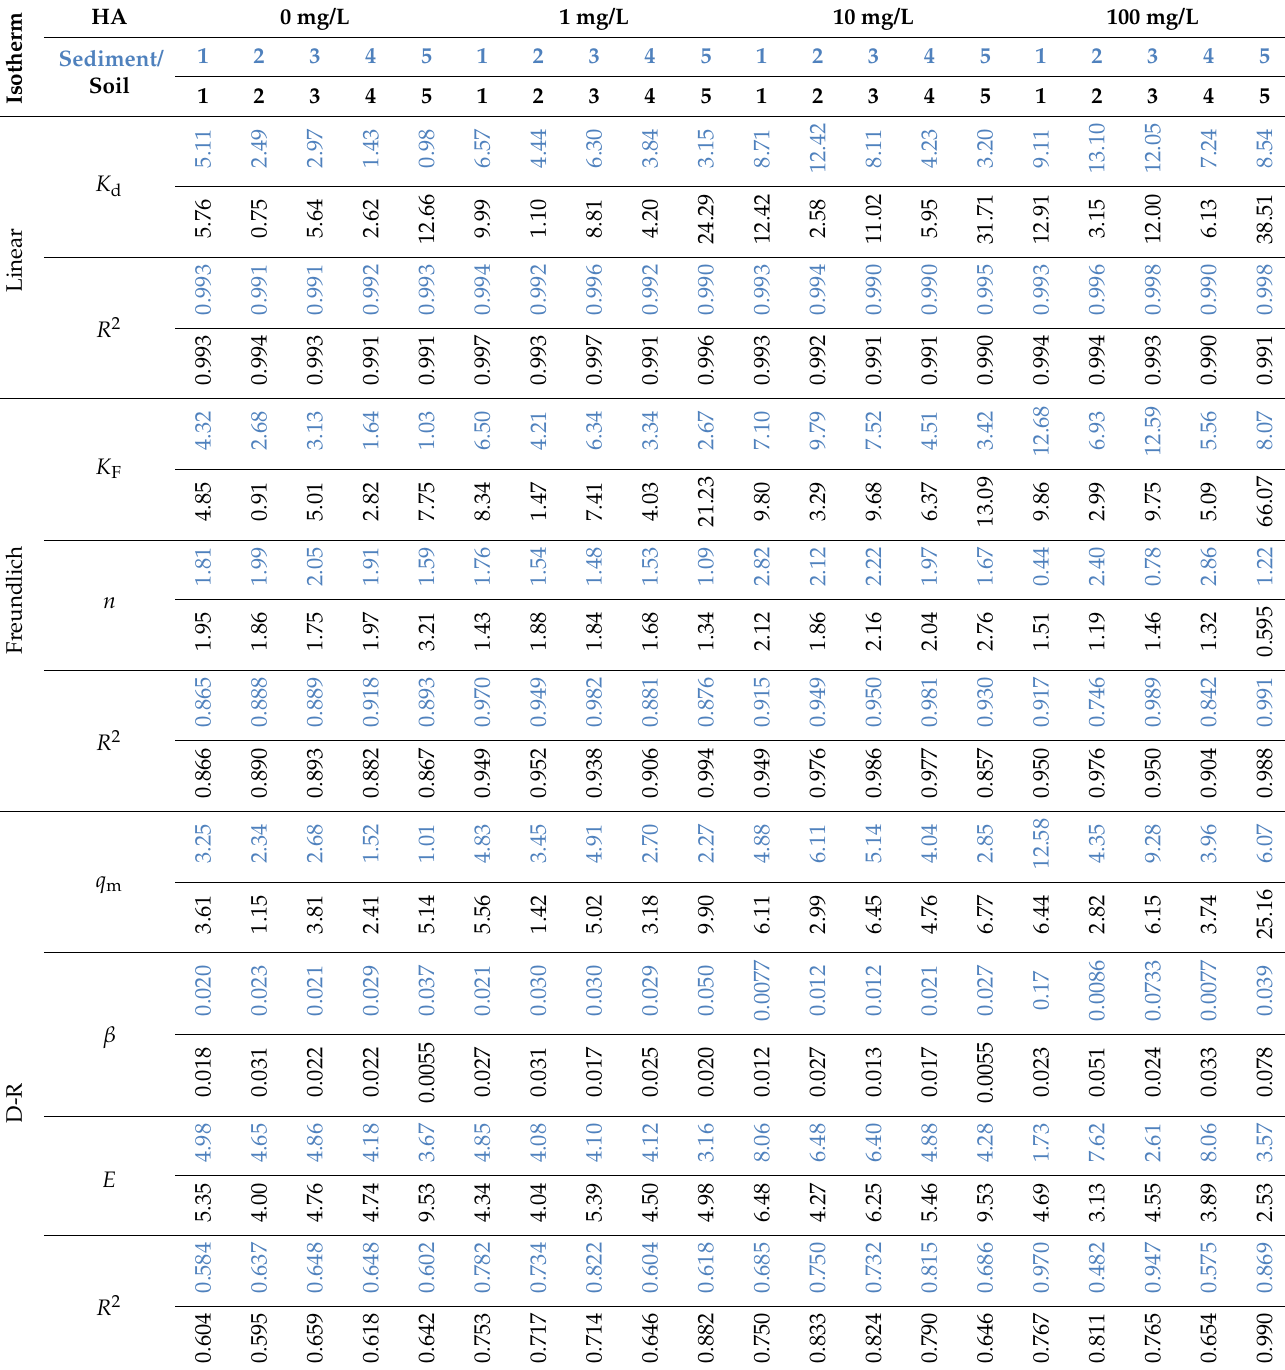
Table 2. The linear, Freundlich, and Dubinin–Radushkevich isotherm parameters for